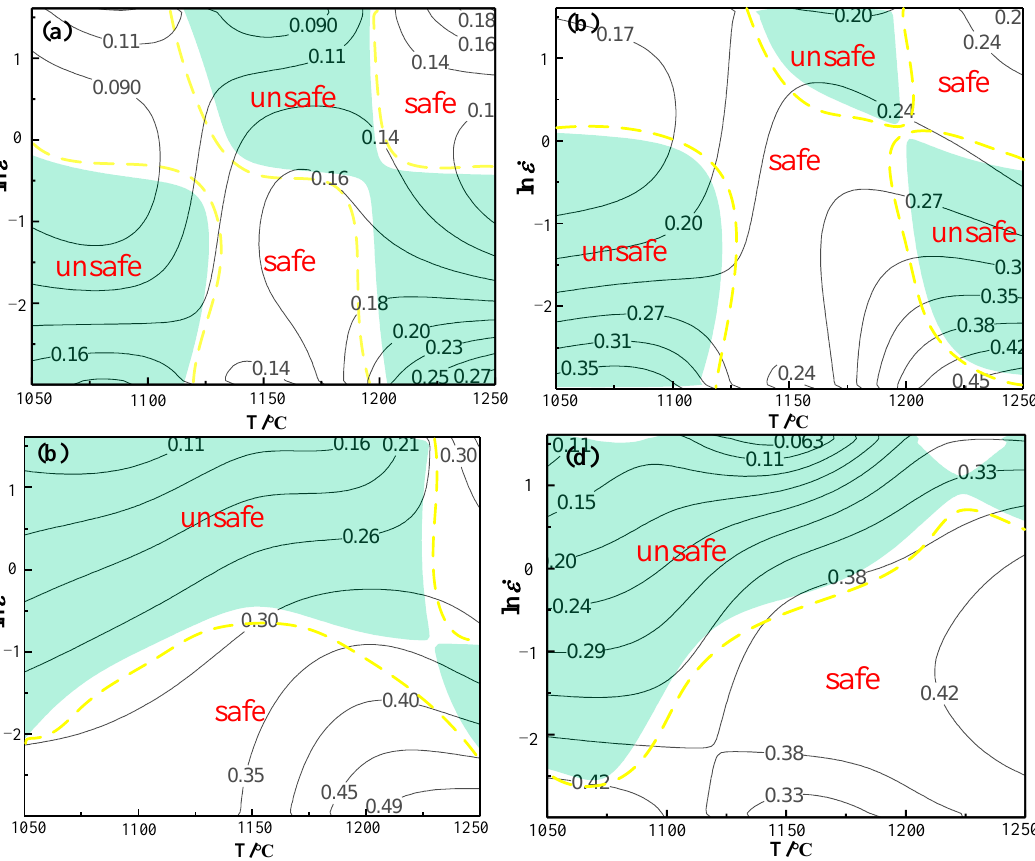
Figure 17. Hot processing maps of X12 ferritic heat-resistant steel at different strains ( a ) ε = 0.1; ( b ) ε = 0.3; ( c ) ε = 0.5; ( d ) ε =